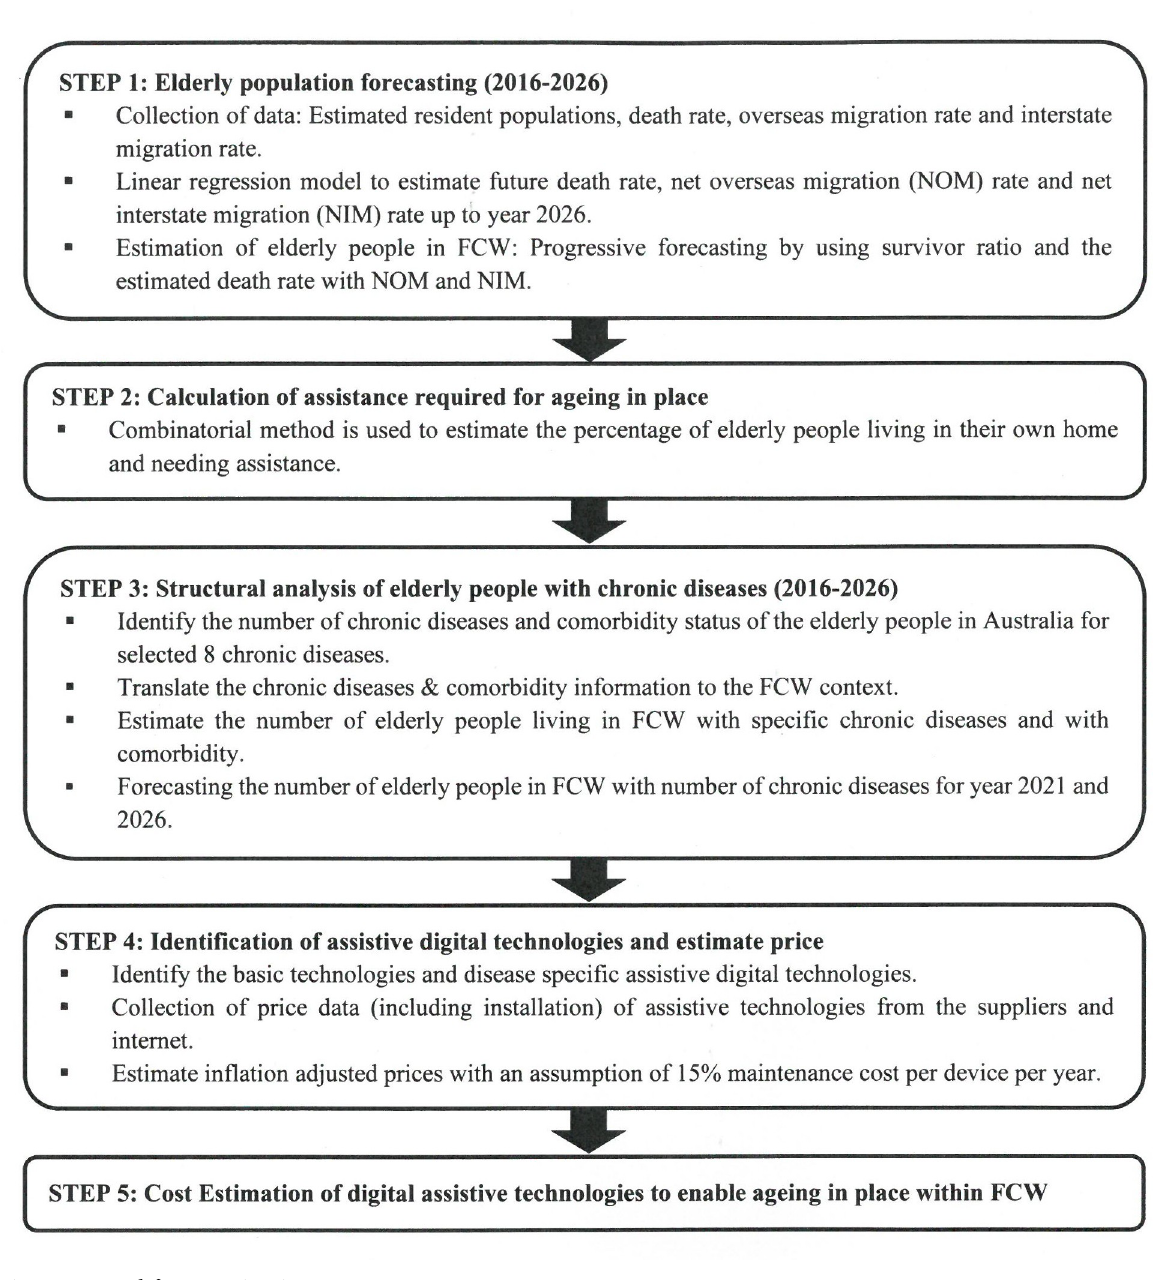
Fig 2. Framework for cost